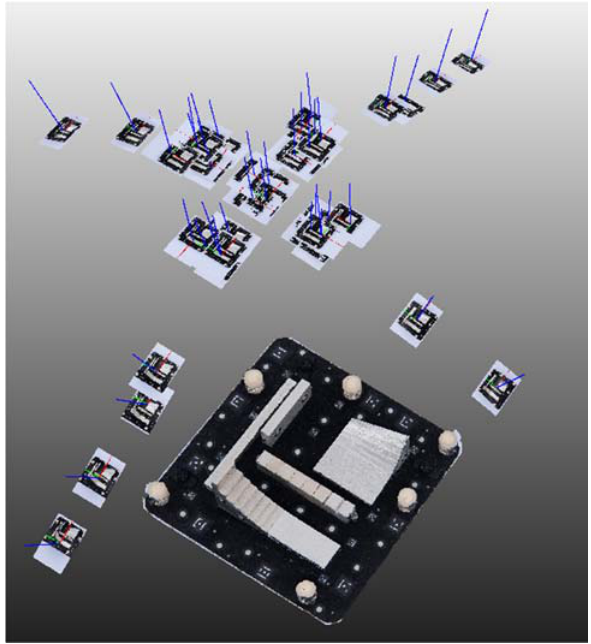
Figure 3. Equivalent camera network for movements of object. Table 1. Interior orientation PhotoModeler resulting from the self-calibrating bundle